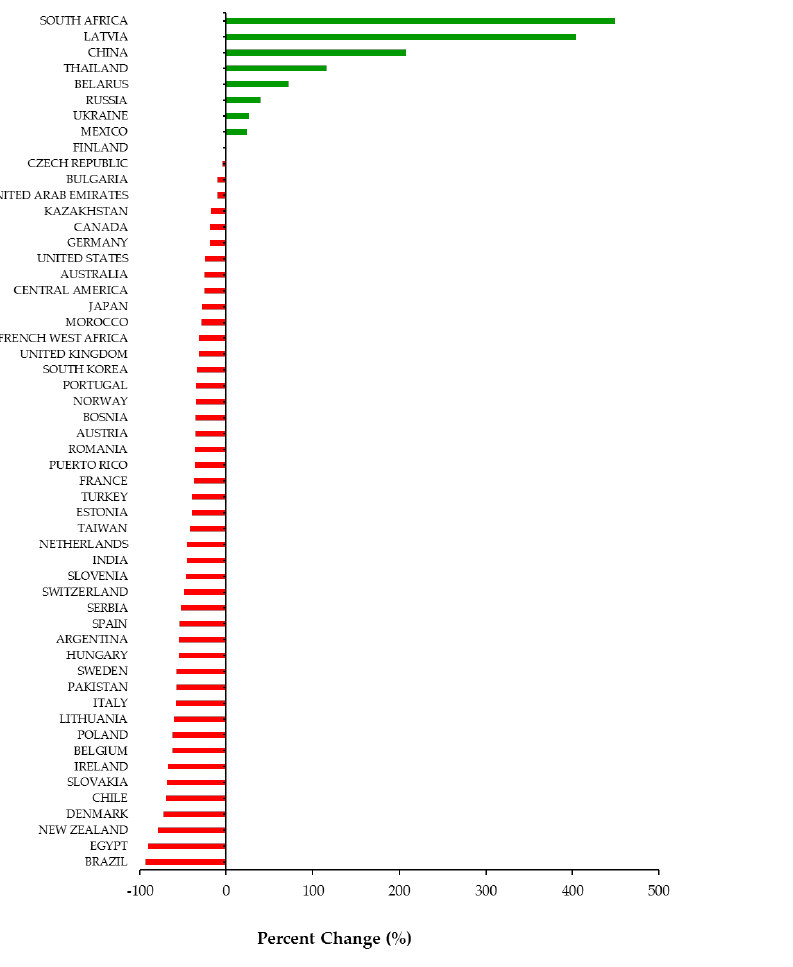
Figure 1. Percent change (%) in utilization of Direct Acting Antivirals by country and region from March to August 2020 compared to March to August 2019.